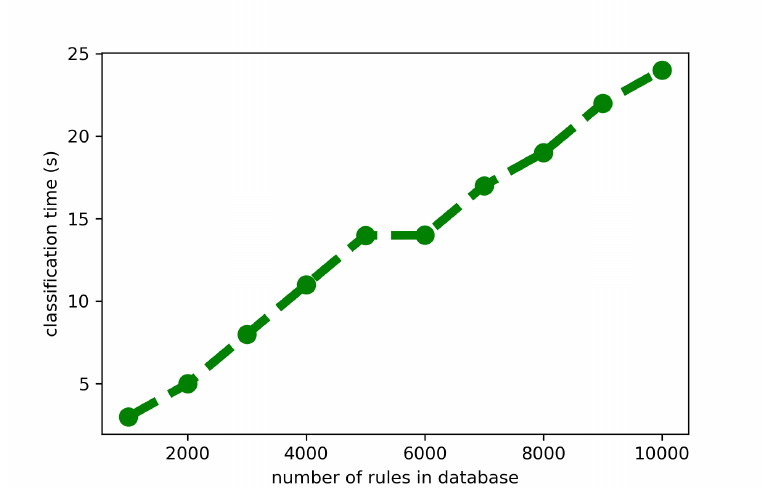
Figure 4. Speed of classification of 1000 random test objects in databases containing from 1000 to 10,000